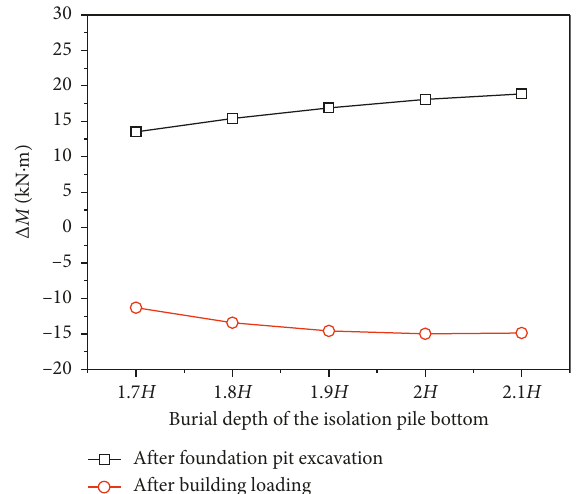
Figure 32: Difference between the additional bending moments.